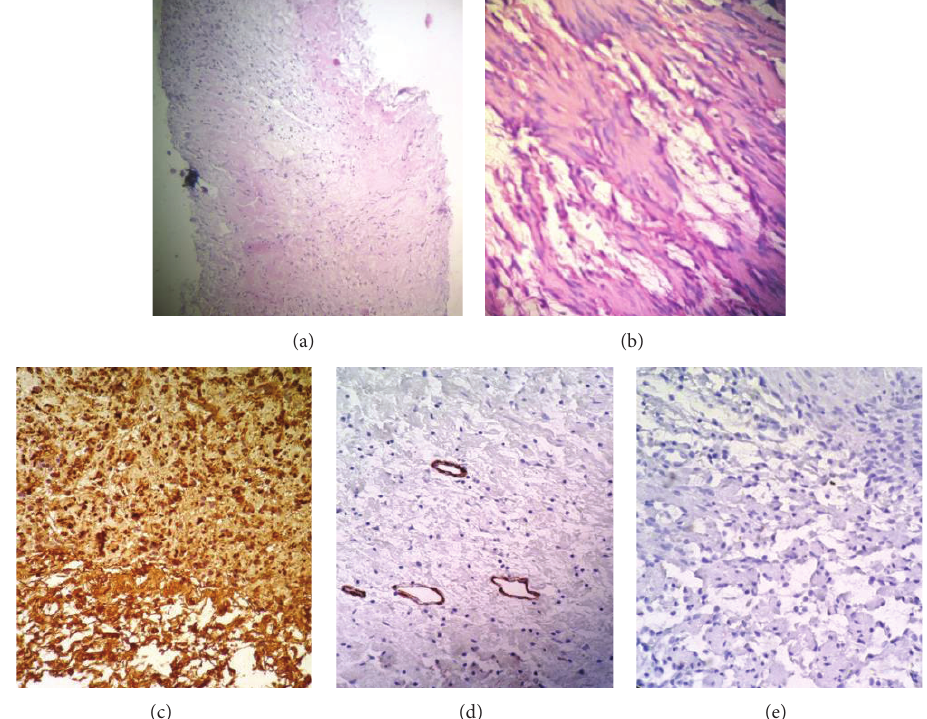
Figure 3: (a) and (b) H&E stained sections: (a) low power view of core needle biopsy: Antoni-A and -B growth pattern × 25, (b) palisading arrangement of spindle shape tumor cells (Verocay bodies) × 100; (c) I.H.C study with S-100 antibody shows positive nuclear reaction (PAP staining × 40); (d) and (e) I.H.C studies with SMA and CD 117 both show negative reaction with tumor cells (PAP staining, D × 40 and E ×